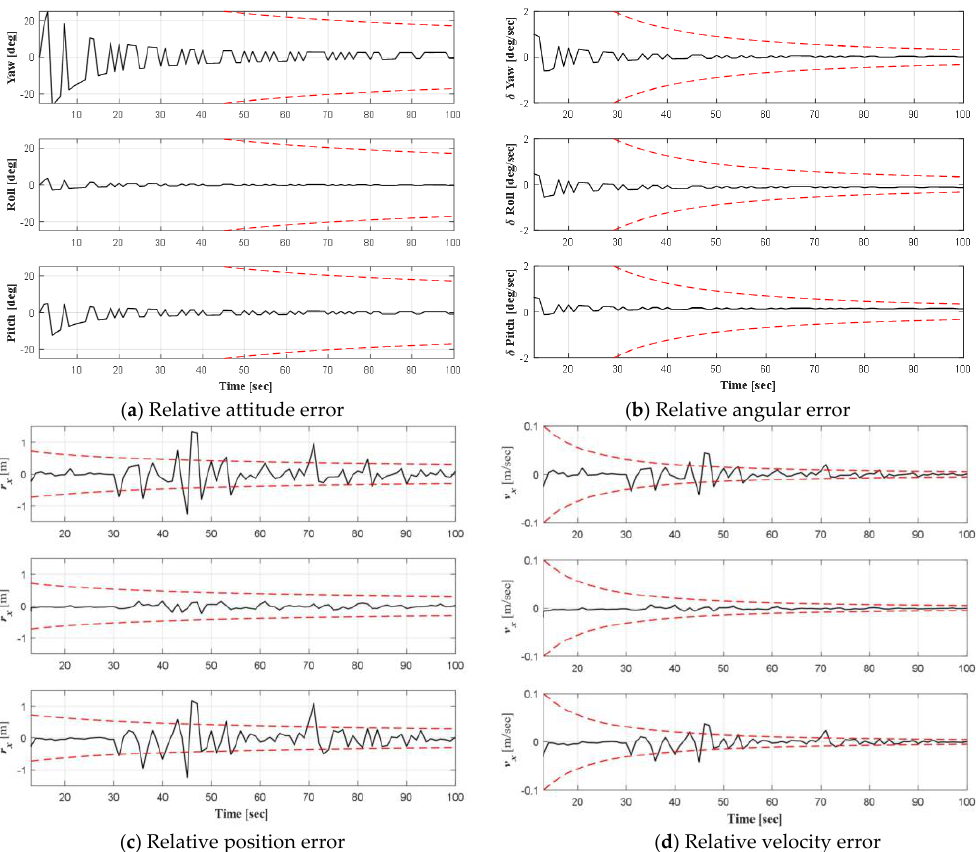
Figure 17. Error analysis after the initialization of the first 100 frames of interception.